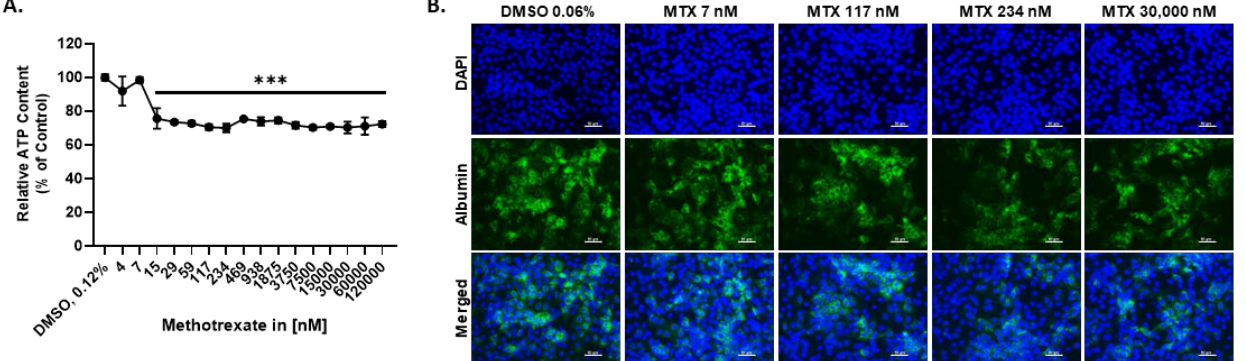
Figure 1. The effect of MTX treatment on HepaRG viability and functionality. HepaRG were exposed to MTX for 72 h. Viability was assessed using the CellTiter-Glo ® Luminescent Cell Viability Assay and expressed as relative ATP content (% of control), N = 6–9 ( A ). The HepaRG were fixed and stained for albumin (green) and counterstained with DAPI (blue). Images were taken using the Zeiss Colibri 7 LED system ( B ). Scale bar representing 50 µm. Graphs represent means ± SD; statistical analysis based on one-way ANOVA; ***, p ≤ 0.001.